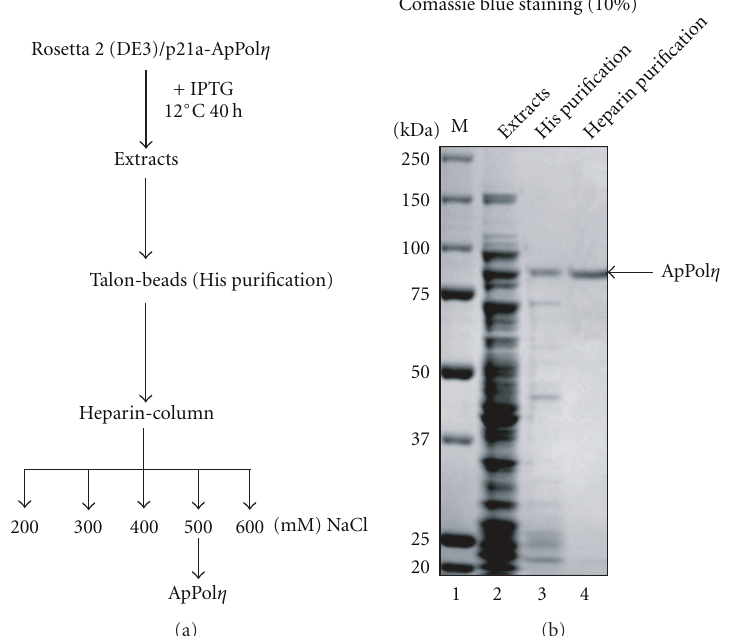
Figure 2: Purification of the recombinant ApPol η protein. Aliquots from various steps of the purification were subjected to 10% SDS-PAGE analysis, and the proteins were visualized by staining with Coomassie Brilliant Blue. ApPol η has a molecular mass of 85 kDa. Lane 1, markers; lane 2, cell extract; lane 3, Talon eluate; lane 4, HiTrap Heparin HP